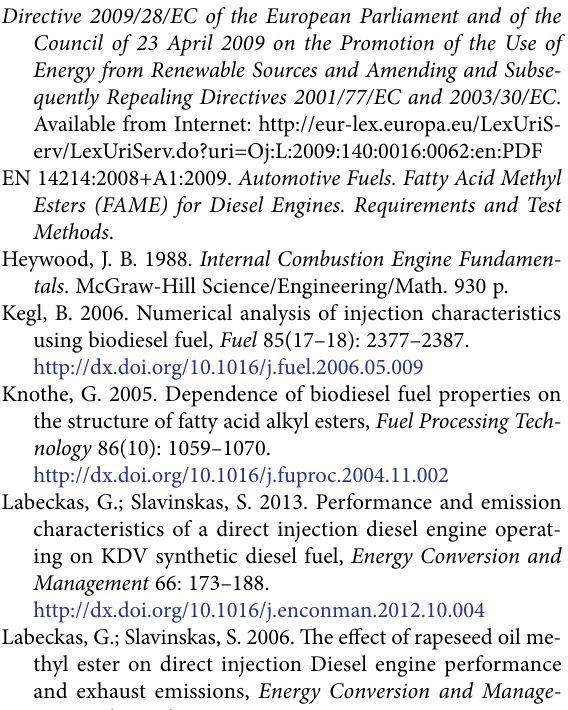
Fig. 11. The smoke opacity of the exhausts as a function of engine load ( bmep